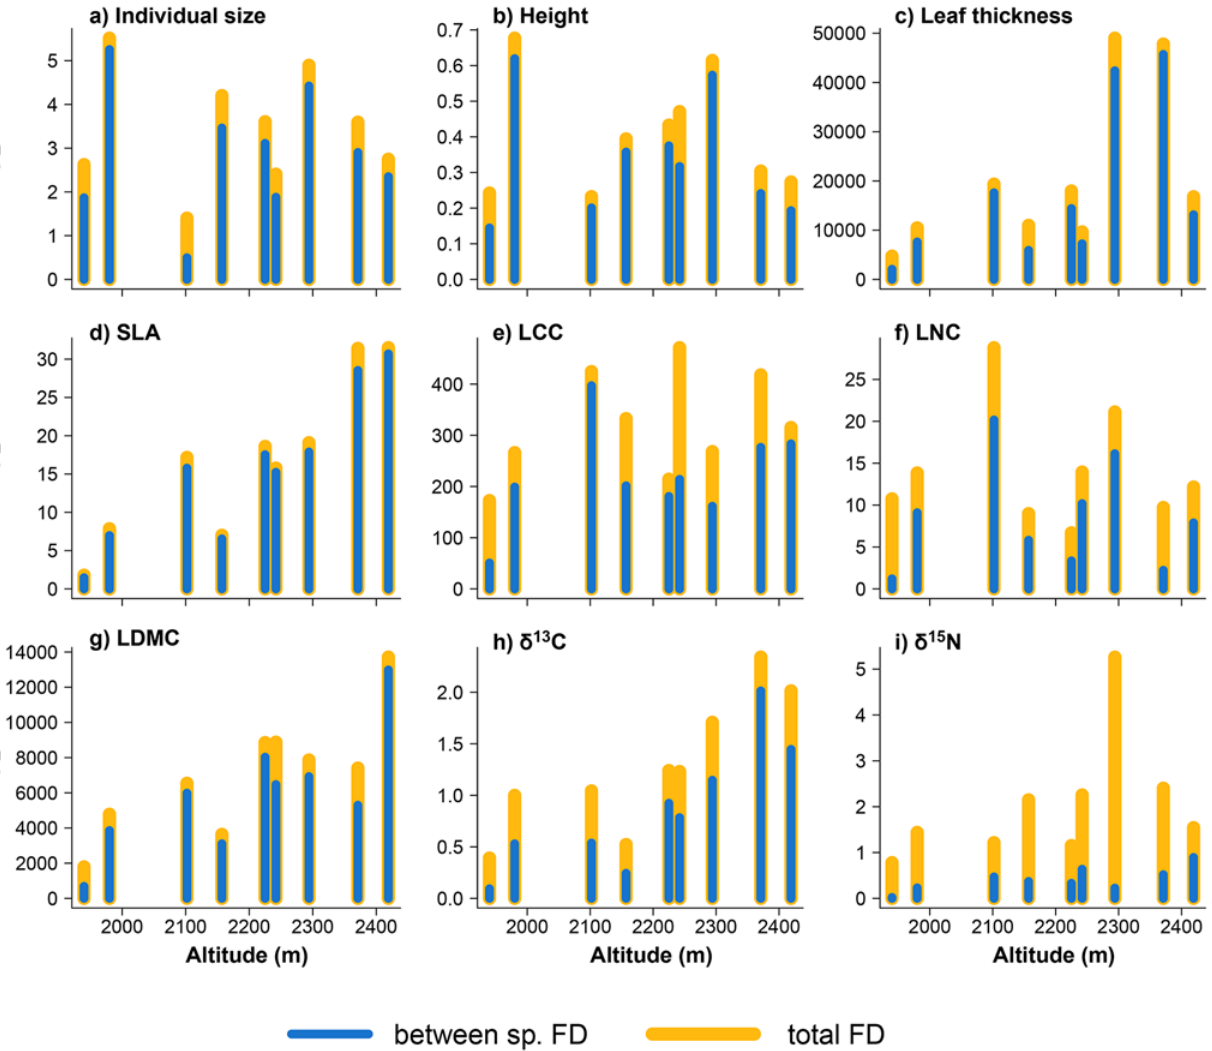
Fig 4. Variation of functional diversity (FD) along altitudinal gradient for each functional trait (a-i). Partition of FD into inter- and intra-specific variability (difference between Total — inter-specific FD) expressed as yellow and blue vertical bars respectively along altitudinal gradient. Trait labels are the same as in Fig.